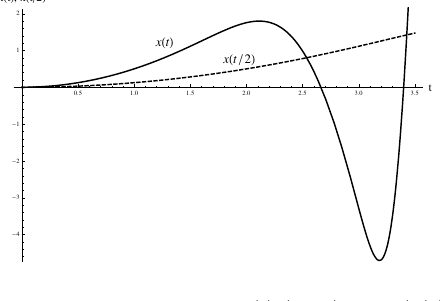
Figure 1. Functions x ( t ) (solid) and x ( t/ 2) (dashed).